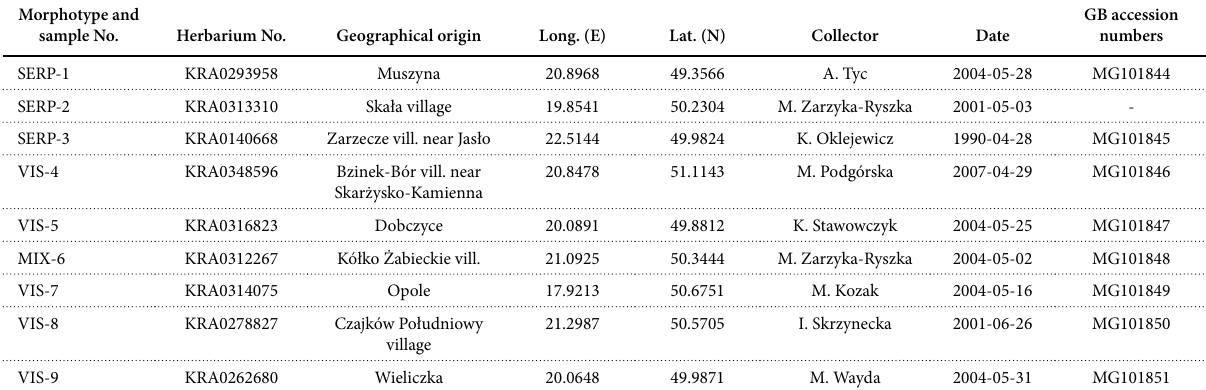
Tab. 3 Samples of Arenaria serpyllifolia s. l. included in DNA study. Morphotype and sample